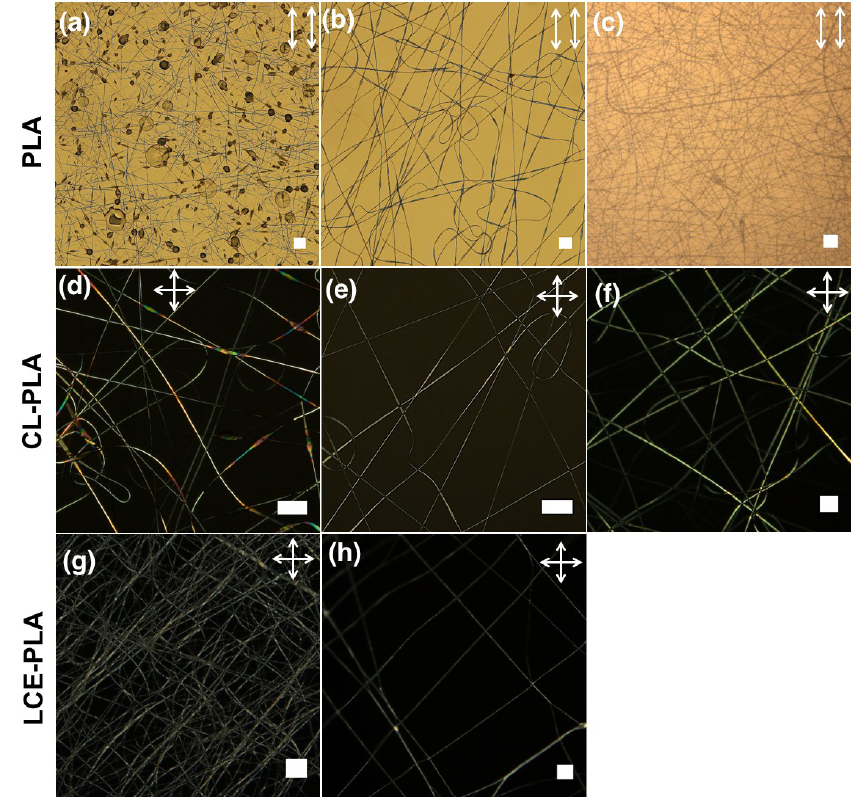
Figure 7. POM of pure PLA fibers spun with a PLA concentration of ( a ) 5; ( b ) 8 and ( c ) 9 wt. % respectively; CL-PLA fibers spun from different solutions: ( d ) mixture 1; ( e ) mixture 2 and ( f ) mixture 3; ( g ) LCE-PLA fibers spun randomly on glass and ( h ) free-hanging (both are UV cured at 55 ◦ C). (scale bars: 200 µ m.) The white double-ended arrows depict the orientation of polarizer and analyzer,